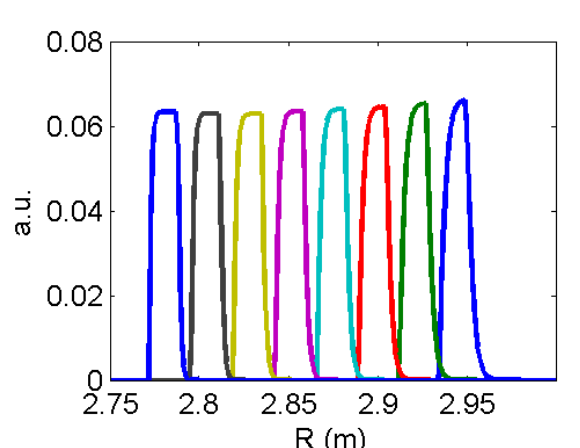
Fig. 5. Channel overlapping at the edge due to the ripple for the reference 1° sight angle. The toroidal waist of the ECEI beam is 6 cm and the channel separation is D F=900 MHz .